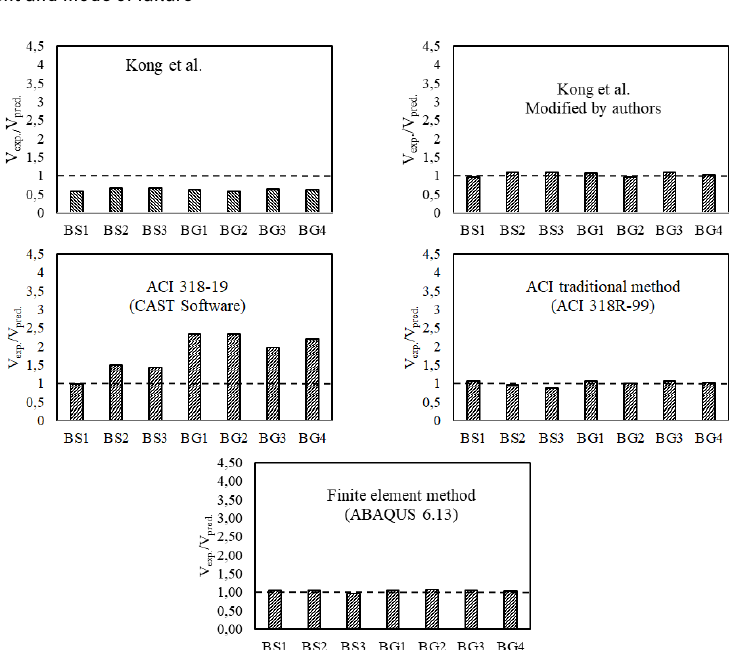
Figure 38: Ratios between Experimental to predicted ultimate shear strength of tested